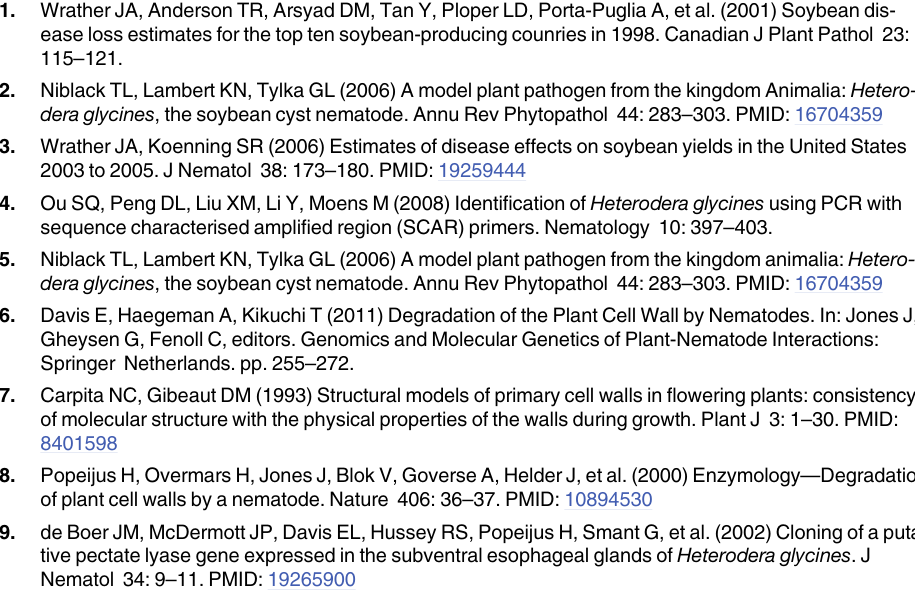
S1 Table. Percentages of protein similarities and identities (bold) of pectate lyases among the different cyst